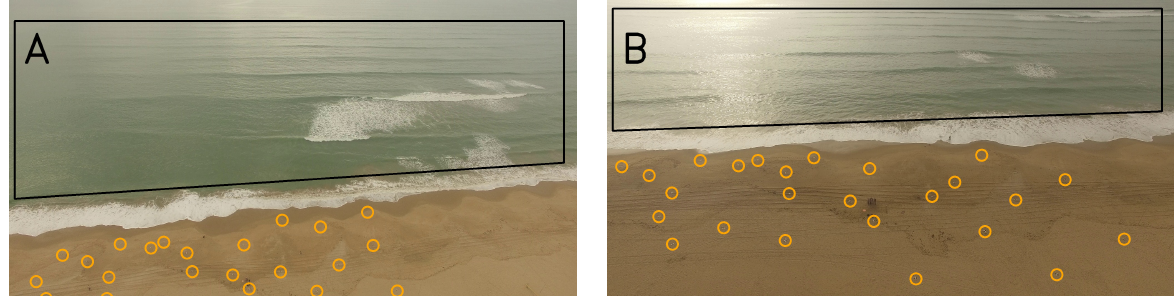
Figure 3. Targets displayed as georeferenced points (GCPs) for videos 1 ( A ) and 2 ( B ). The visible targets are marked with circles. The black quadrangles stand tor the pixel domains